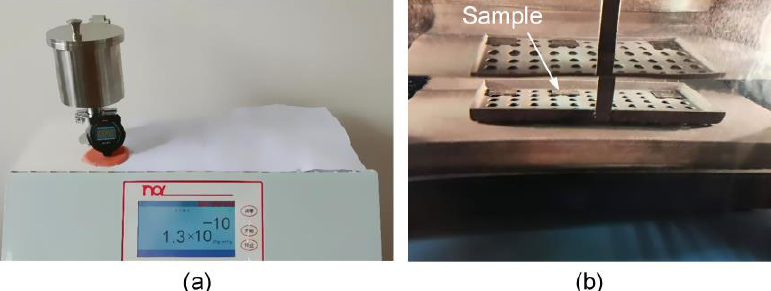
Figure 9. Leakage detection of SiC cavity structure: ( a ) the fine leak detection; ( b ) the coarse leak detection.